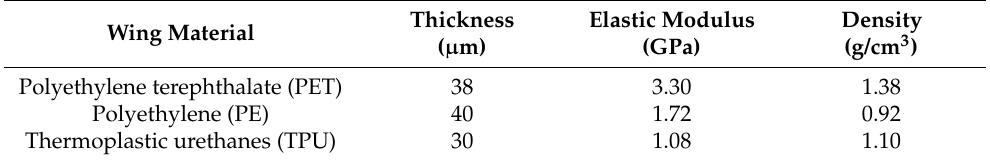
Table 1. Material properties of the tested Wings. Thickness Elastic Modulus Density Wing Material ( µ m) (GPa) (g/cm 3 ) Polyethylene terephthalate (PET) 38 3.30 1.38 Polyethylene (PE) 40 1.72 0.92 Thermoplastic urethanes (TPU) 30 1.08 1.10